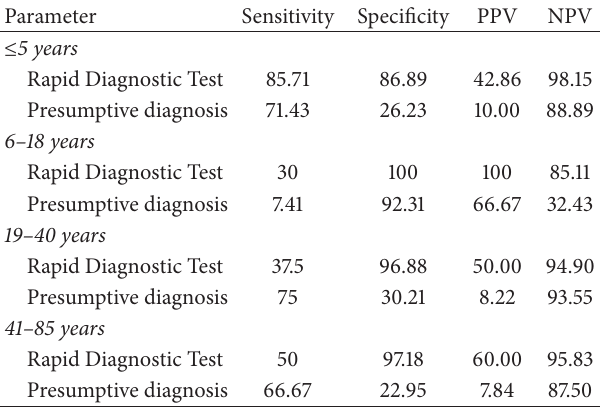
Table 2: Age stratified performance of rapid and presumptive diagnostic test using field microscopy as a gold standard.